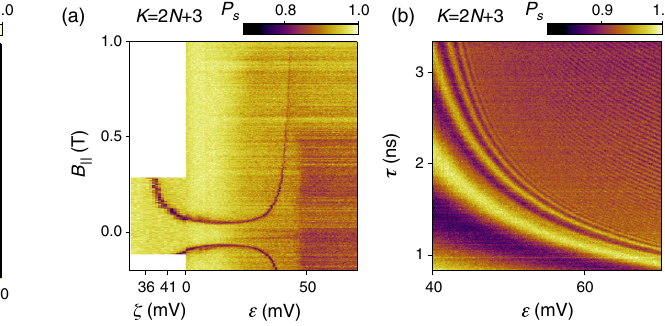
FIG. 10. Leakage spectroscopy (a) and time-resolved measure- ment of exchange oscillations (b) for the multielectron dot occupied by 2 N − 5 electrons.